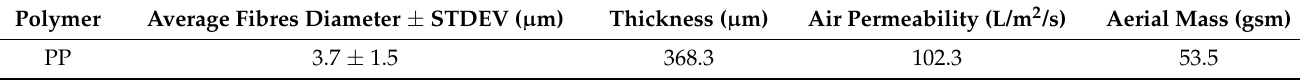
Figure 6. Morphology of (PP) microfibres under an optical microscope. Table 5. PP microfibres characteristics.